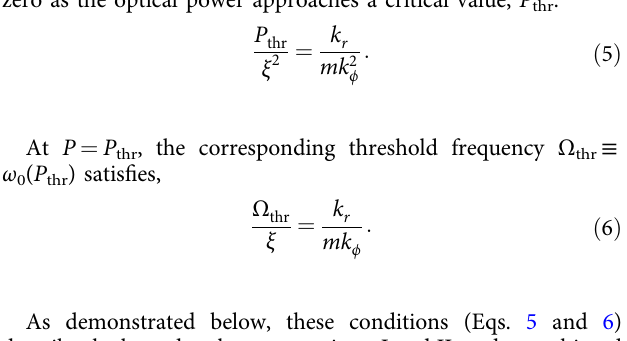
Table 1 Comparison summary for stochastic motion in CP and LP beams in regime I Quantity